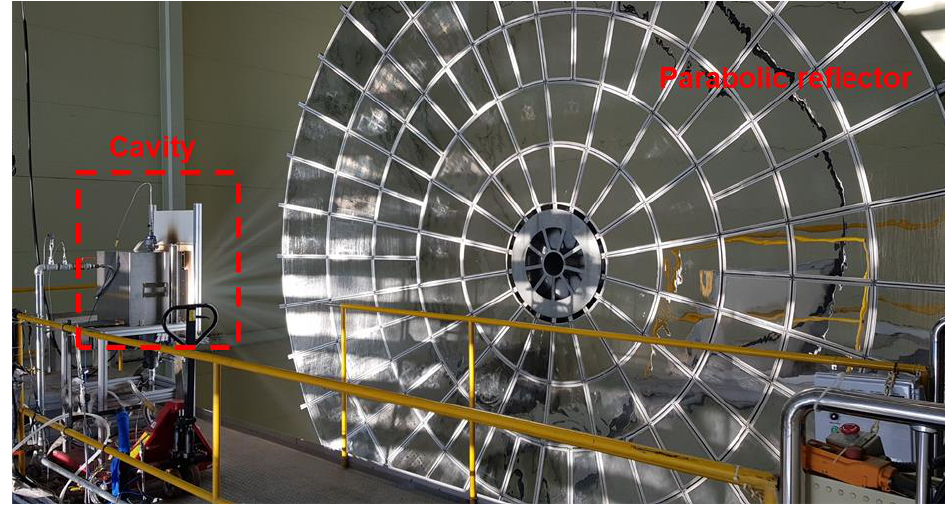
Figure 5. Installed reactor in a solar furnace.